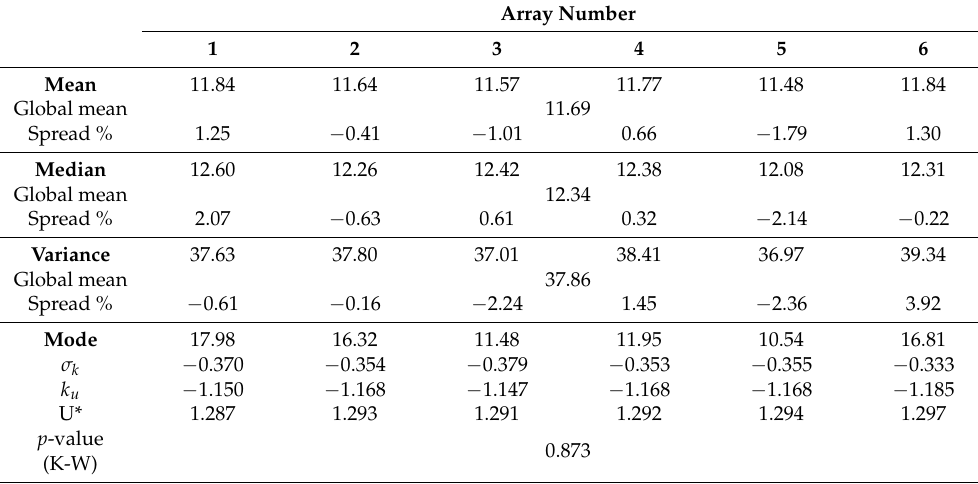
Table 3. Mean, median, and variance of the daily energy (in kWh) produced by each array and relative spreads values for 12 months. Skewness, kurtosis and p